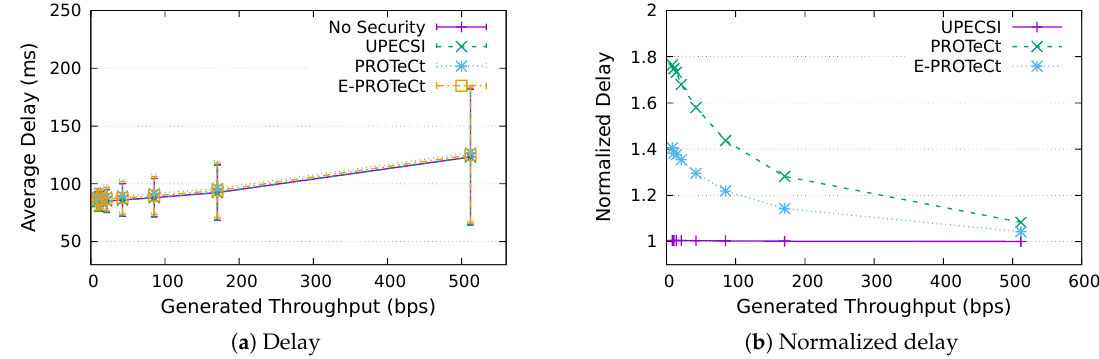
Figure 14. Delay analysis for an IoT network with 32